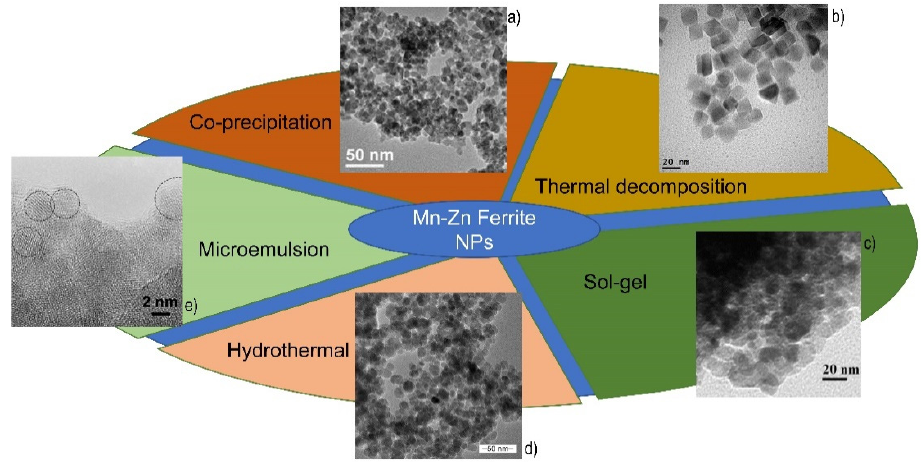
Scheme 1. Schematic figure of the synthetic methods described for the preparation of Mn-Zn Ferrite nanoparticles for biomedical applications. Adapted with permission from ( a ): [20]; ( b ): [31]; ( c ): [40]; ( d ): [38]; ( e ): [35].